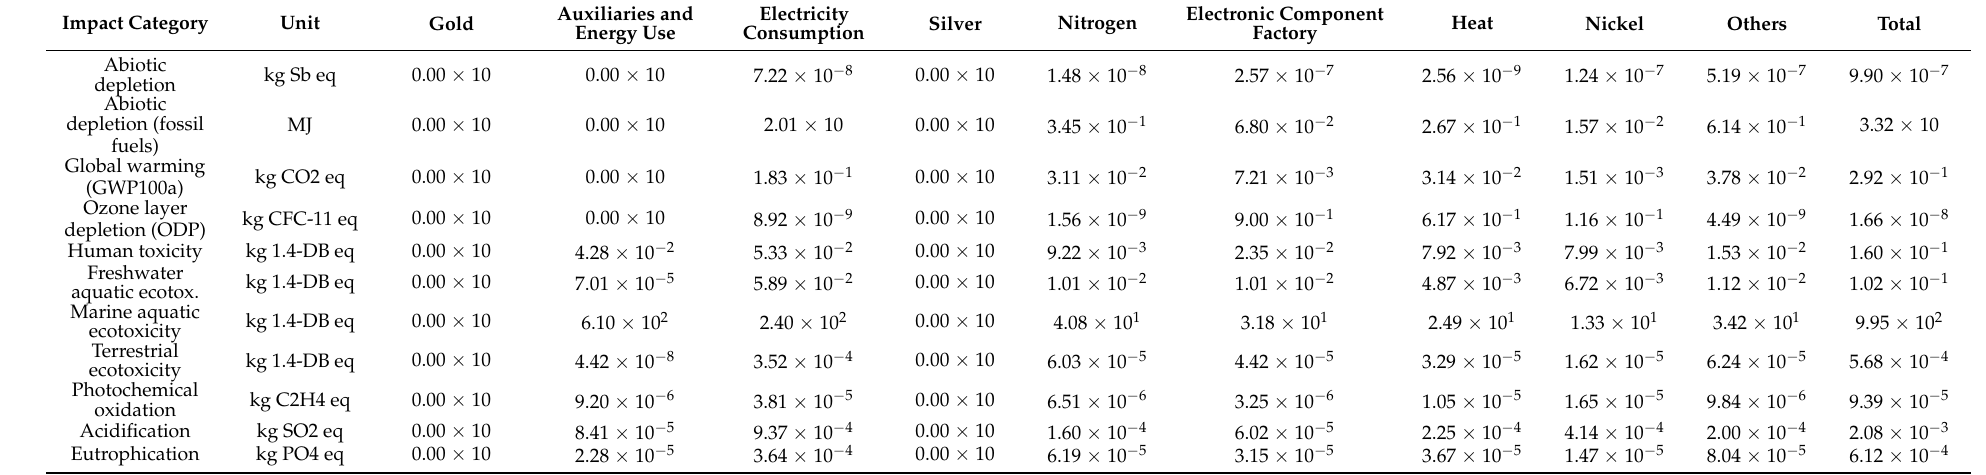
Table 9. Detailed study of the environmental impact of diode BZX84B10LT1G (impacts for 1 g of